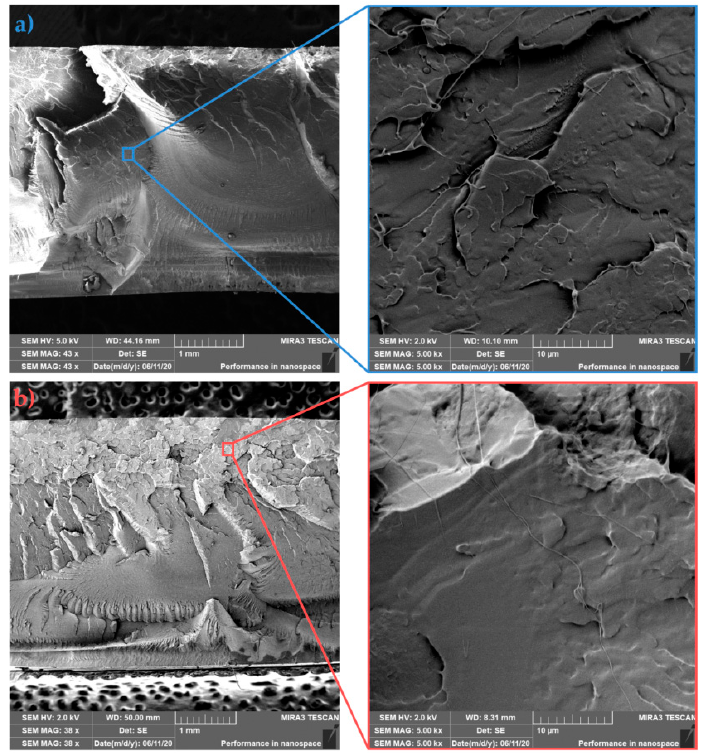
Figure 9. Fracture morphologies of ( a ) cold and ( b ) hot mold PLLA.